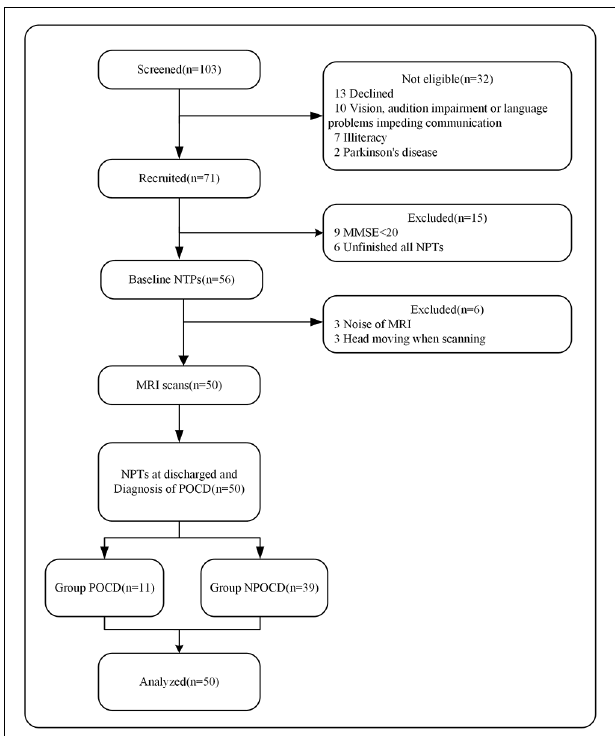
FIGURE 1 | Flow diagram for study assessments. NPTs, neuropsychological tests; MRI, magnetic resonance imaging; POCD, postoperative cognitive dysfunction; NPOCD,